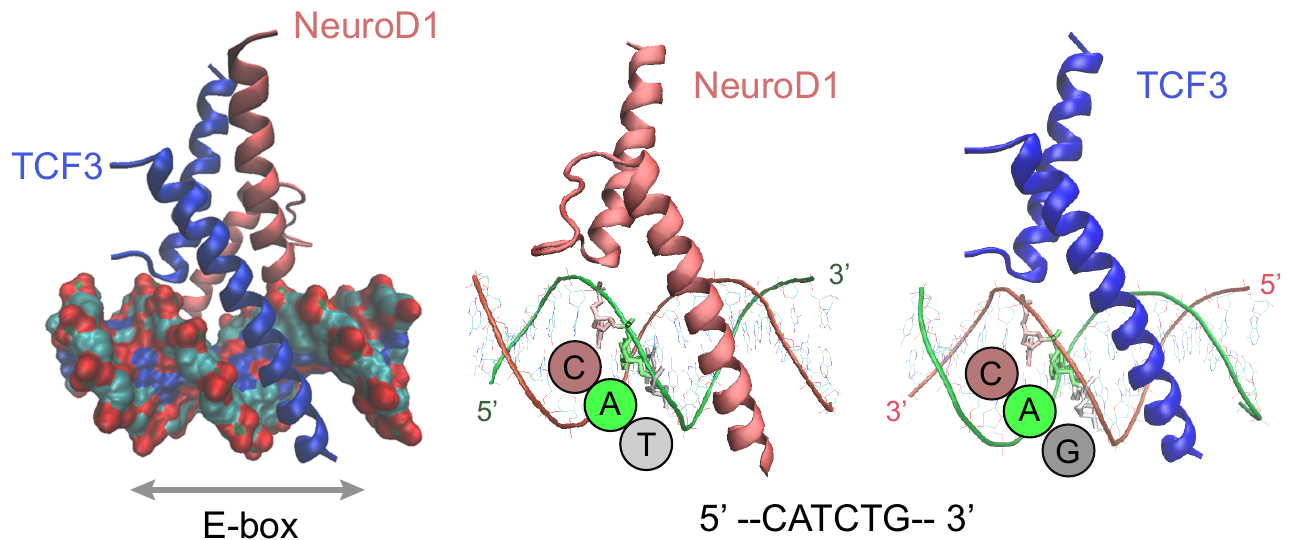
Figure 1. Structure of Tcf3-Neurod1 heterodimer bound to a CATCTG E-box. The bHLH domains of Neurod1 and Tcf3 are shown in red and blue, respectively. Neurod1 binds the CAT half-site of the E-box in the forward strand (pink) and Tcf3 binds the CAG half-site in the reverse strand (green). This representation has been produced with VMD v1.9.4 from the published X-ray crystal PDB:2ql2 from Longo et al. [40].